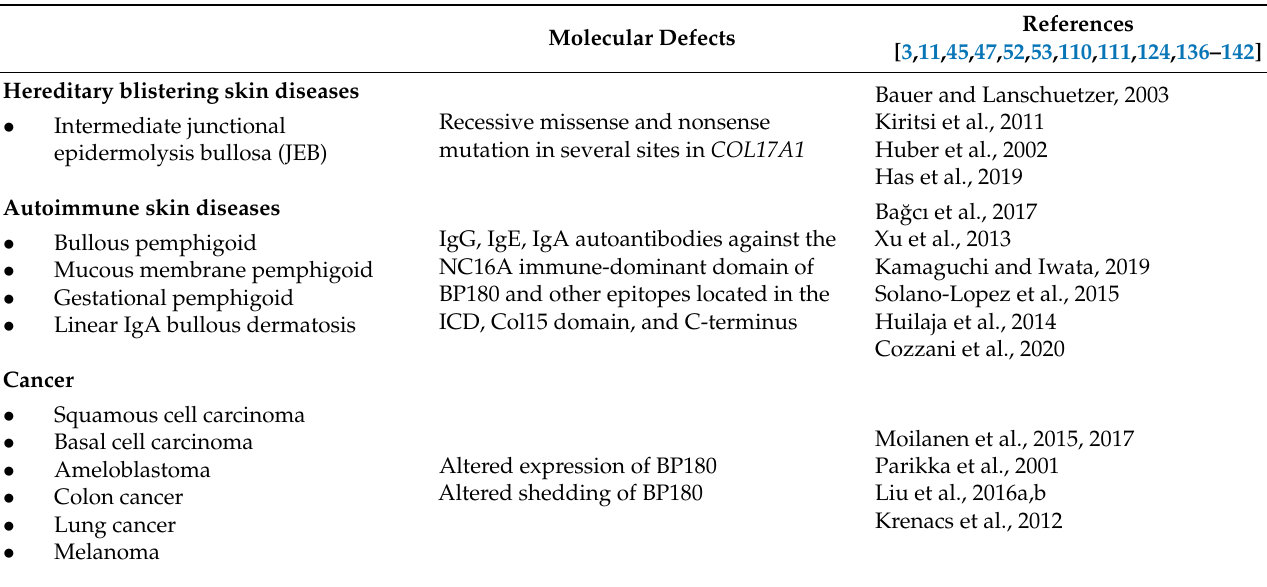
Table 1. Diseases with BP180